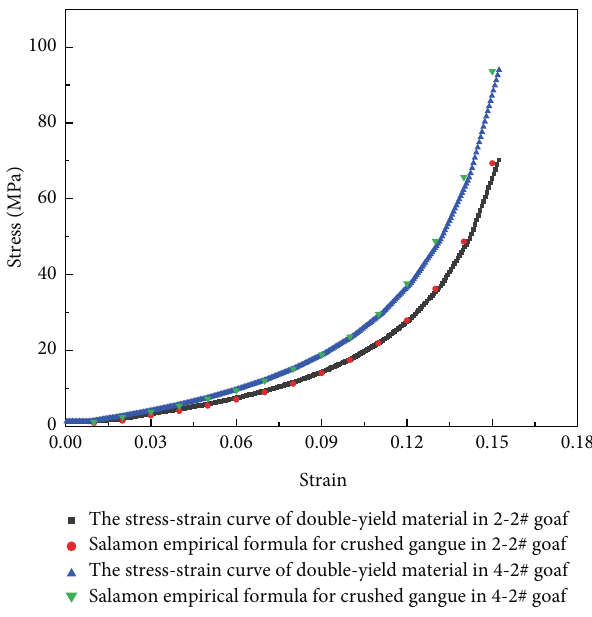
Figure 4: Iteratively fi tted results. Table 4: Parameters of double-yield materials in 4-2 goaf.